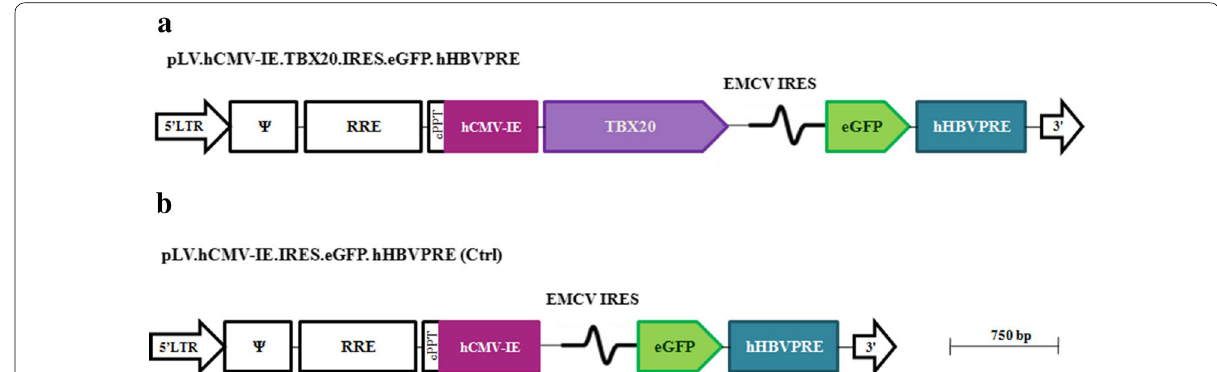
Fig. 1 Map of LV DNA in the LV shuttle plasmids. pLV.Tbx20 ( a ), pLV.Ctrl ( b ). 5 ′ LTR chimeric 5 ′ long terminal repeat including the Rous sarcoma virus U3 region as well as the HIV1 R and U5 regions. Ψ HIV1 packaging signal, RRE HIV1 Rev‑responsive element, cPPT HIV1 central polypurine tract and termination site, hCMV-IE human cytomegalovirus immediate early gene promoter, Tbx20 coding sequence of desired gene, EMCV IRES encephalomyocarditis virus internal ribosomal entry site, EGFP enhanced green fluorescent coding sequence, hHBVPRE human hepatitis B virus posttranscriptional regulatory element, 3 ′ LTR 3 ′ HIV1 long terminal repeat involving a deletion in the U3 region to render the LV